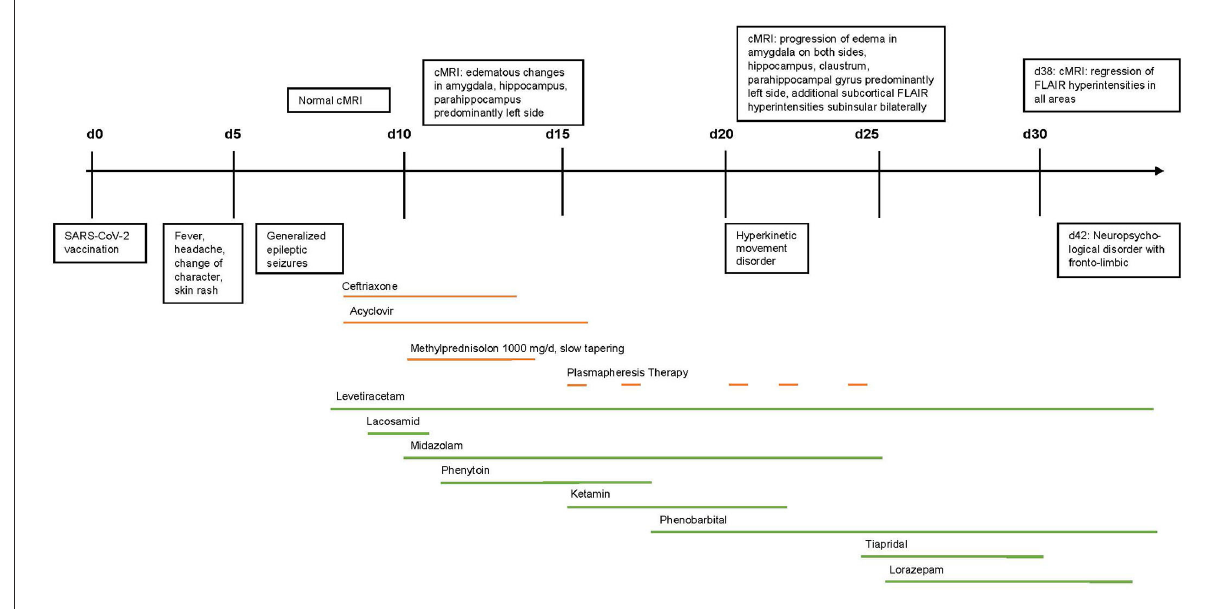
FIGURE1 Timeline of clinical development, therapy, and MRI-findings.